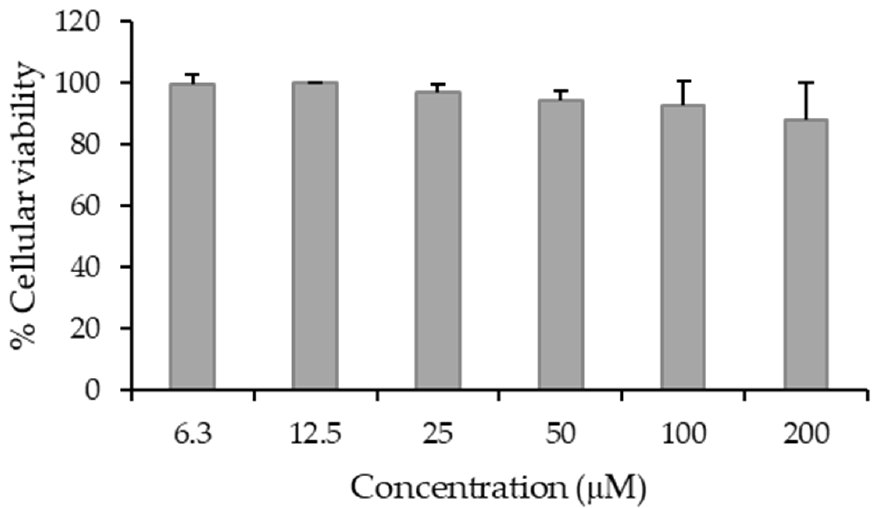
range of 6.3–200 µ M. Results are expressed as a mean ± SD of two independent experiments with at Figure 6. Cellular viability (%) of U87 cells upon 6 h treatment with CMBA at concentrations in the least six range of 6.3–200 µM. Results are expressed as a mean ± SD of two independent experiments with at least six replicates.